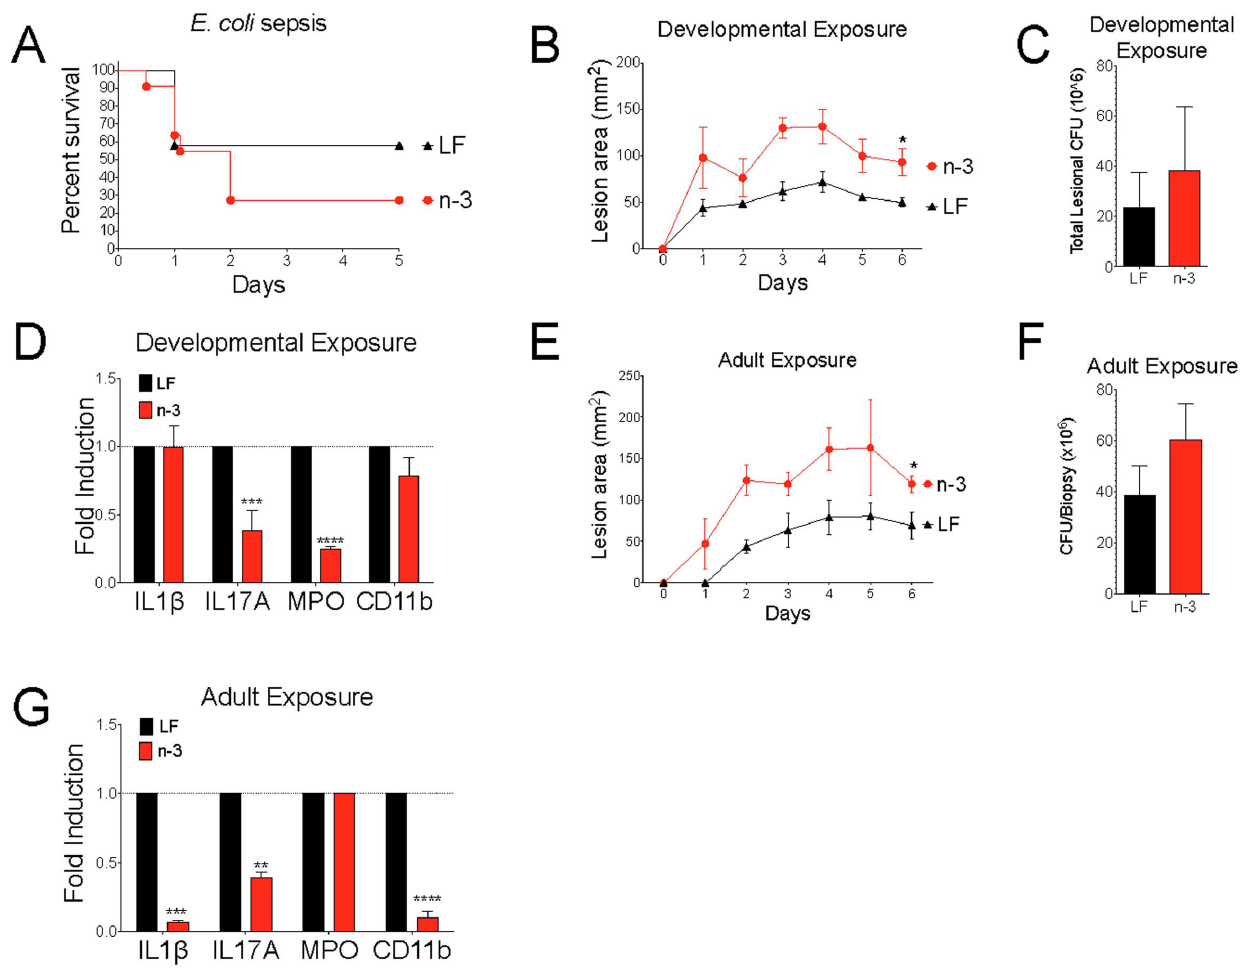
Figure 4. Omega-3 consumption altered MRSA susceptibility. (a) Survival after infection with E. coli 01 K18 in pups of breeders exposed to LF or n 2 3 diet (n=10–12). (b–g) Staphylococcus aureus (MRSA USA300) skin infection in male BALB/c mice. Lesion sizes (b), CFU (c), and mRNA expression in skin abscess tissue normalized against LF controls (dotted line) (d) (n=5–6) in offspring mice. Lesion sizes (e), CFU (f), and mRNA expression in skin abscess tissue normalized against LF controls (dotted line) (g) (n=10) in adult male mice. Results are representative of two (d and g) or combined from 2–3 (a–c and e–f) independent experiments and displayed as mean + s.e.m. Significance determined by t test (b–c, e–f), ANOVA with Bonferroni’s correction (d and g), or Kaplan-Meier (a). n designates mouse number per group.